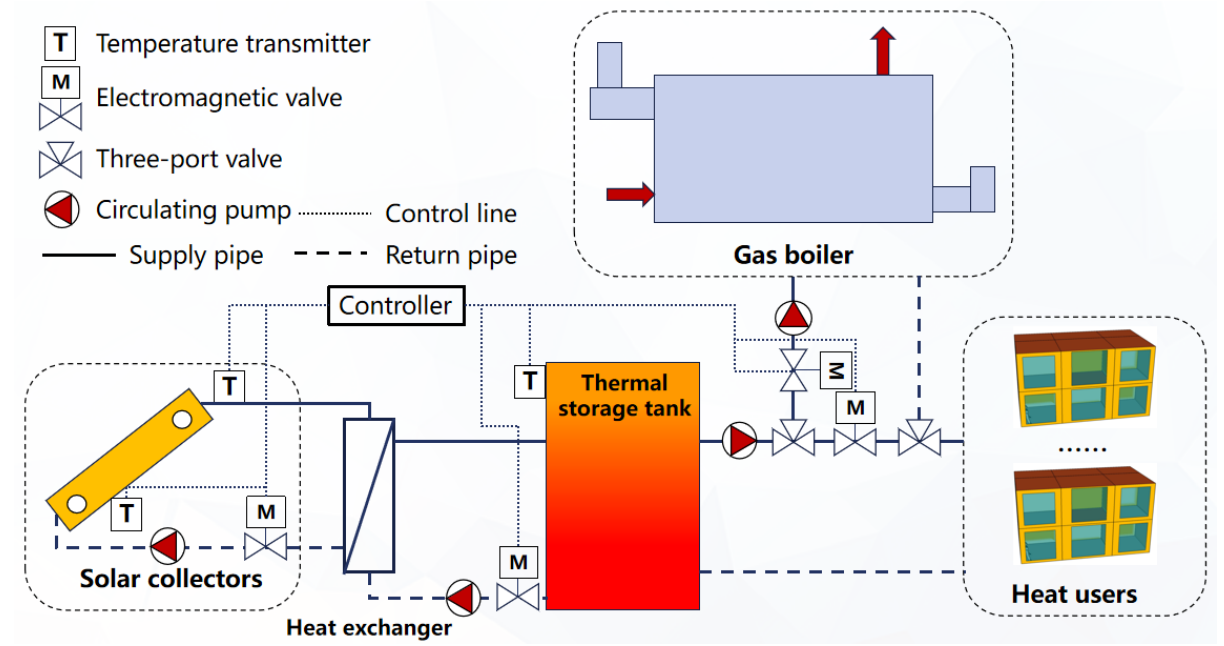
Figure 2. Schematic diagram of the centralized solar heating system in each building